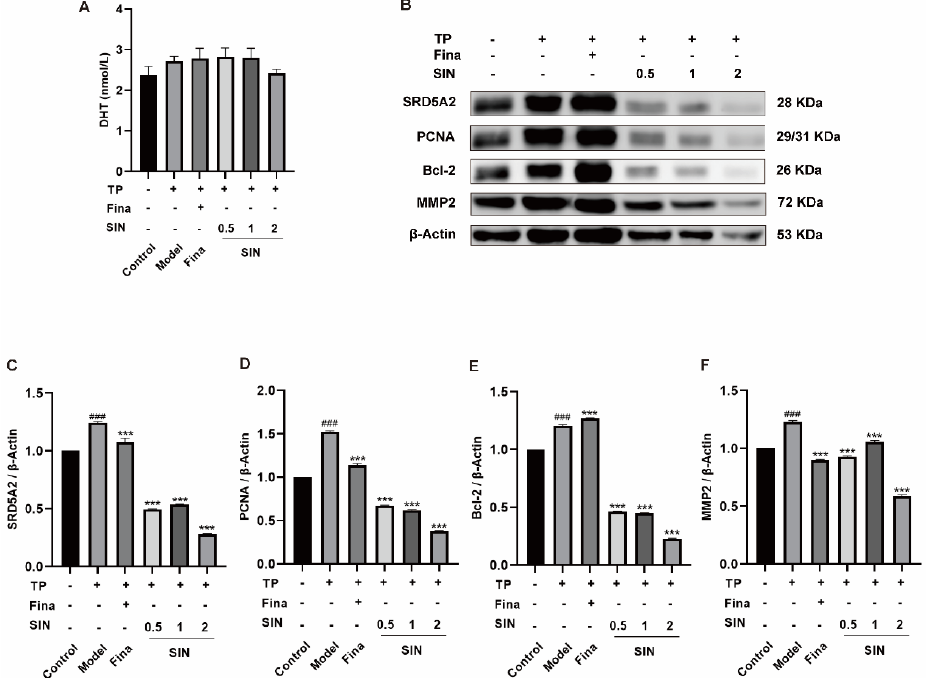
Figure 4. Effect of SIN administration on the expression of related proteins in the PG tissue of mice with TP-induced BPH. ( A ) The level of DHT in serum. ( B ) Effect of SIN administration on the expression of related proteins in the PG tissue of mice with TP-induced BPH. Protein quantification for ( C ) SRD5A2, ( D ) PCNA, ( E ) Bcl-2, and ( F ) MMP2 versus β -tubulin. Data the means ± SEM. ### p < 0.001 versus the control group; *** p < 0.001 versus the model group. Fina, finasteride; SIN, sinomenine hydrochloride; SRD5A2, steroid 5 alpha-reductase 2; PCNA, proliferating cell nuclear antigen; Bcl-2, B-cell lymphoma-2; MMP2, matrix metallopeptidase 2.